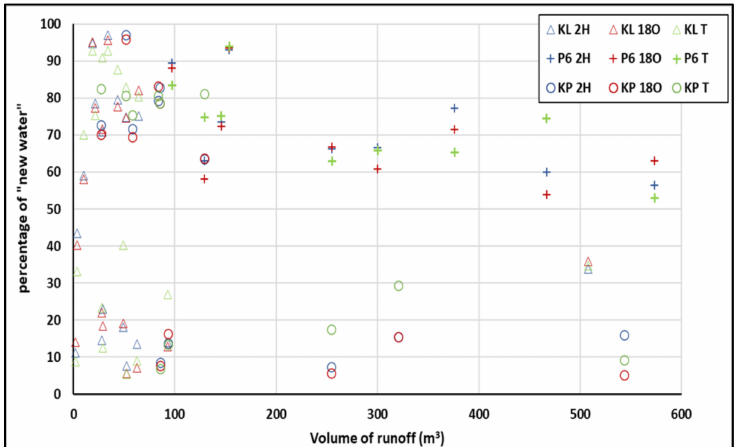
Figure 6. Proportion of new water in total runoff volume according to separation based on 2 H and 18 O isotopes and on temperature in 38 events in three